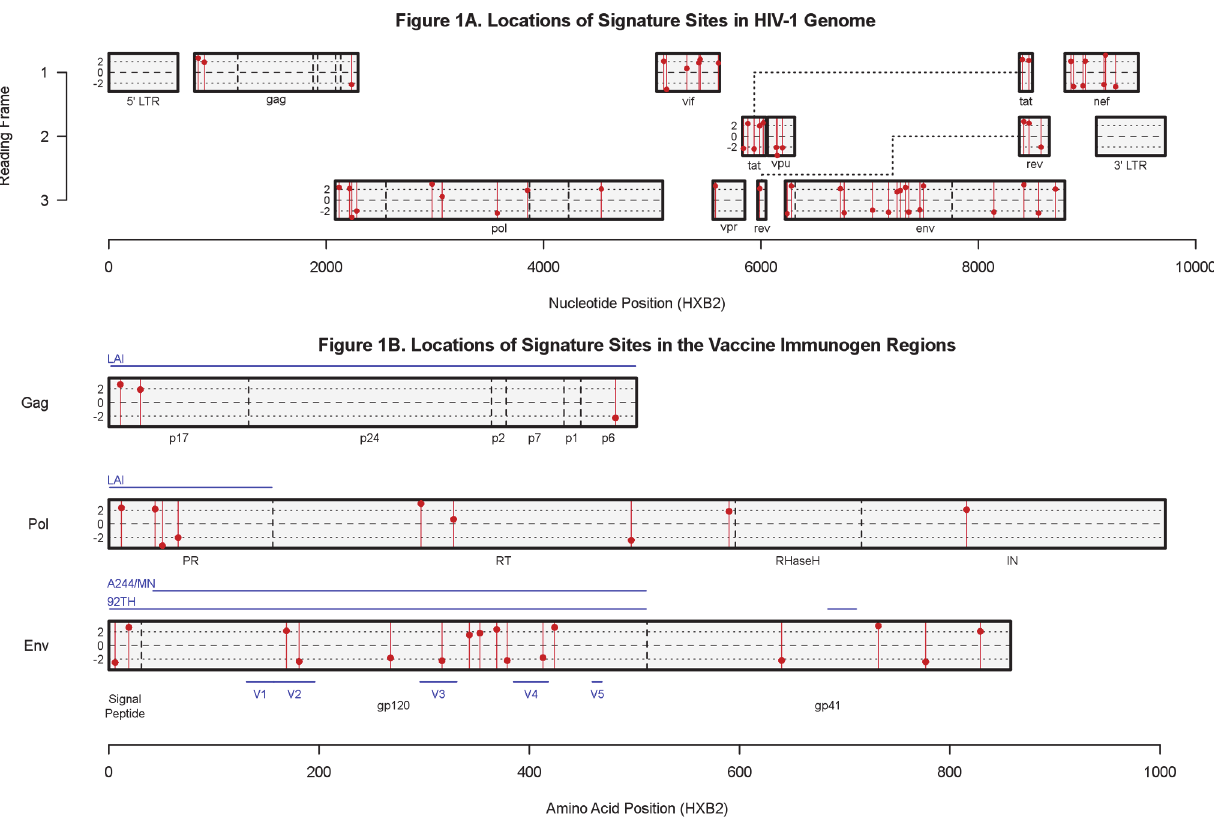
Figure 2. Signature sites by HIV-1 protein. All sites with evidence for a different amino acid distribution in vaccine versus placebo sequences relative to a reference residue (unadjusted p < 0.05) by any of the site-scanning methods DVE, GWJ, or MBS. Panel (A) depicts signature sites found in the full HIV-1 genome, including in vaccine-immunogen regions (relative to a vaccine immunogen sequence) and non-vaccine-immunogen regions (relative to the consensus AE sequence) and (B) depicts a more detailed view of the vaccine immunogen regions in Gag, Pol, and Env. The blue horizontal lines above the protein regions in panel (B) indicate the regions included in the vaccine immunogen sequences, and the blue lines below the Env protein region indicate the positions of the variable loops. Signature sites are indicated by red vertical lines, with a red point that is placed on the line as an indicator of the magnitude of the site ’ s test statistic using the GWJ method, which is a t statistic comparing substitution weights across treatment groups. For sites with multiple reference AAs, the red point indicates the largest magnitude of the multiple test statistics. The black dashed horizontal lines in the middle of the gene and protein regions indicate the zero-point for the test statistic, so the farther away the point is from the center line, the more significant it was observed to be with this method. Points above the dashed line indicate that a site was found to have a “ vMatch ” sieve effect, while points below the dashed line indicate “ vMismatch ” signature